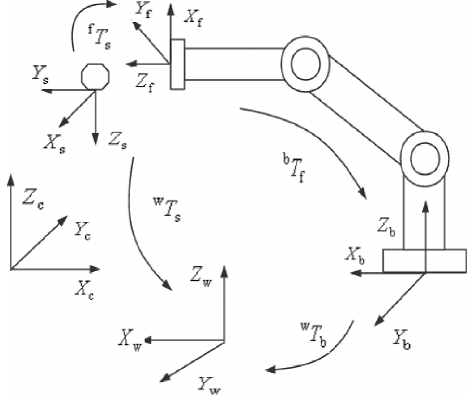
Figure 5. Coordinate system conversion relationship.